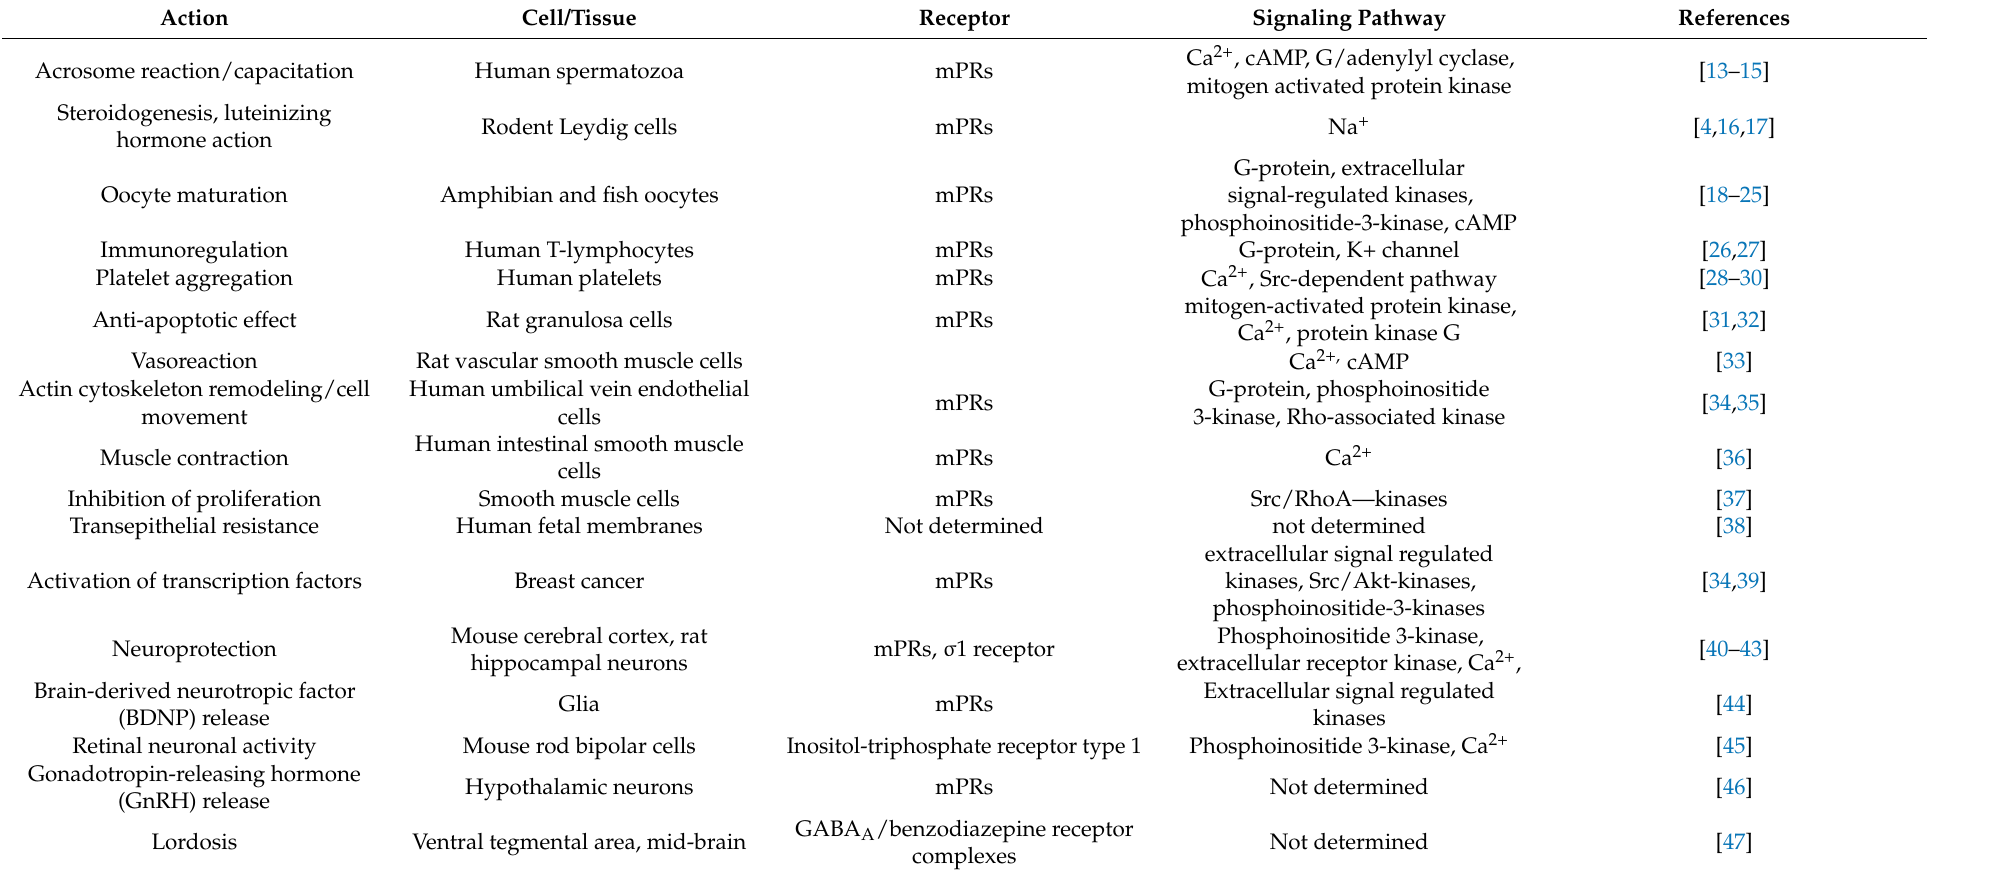
Table 1. Non-genomic effects of progesterone across humans and animals. In the given receptor types, mPRs represent membrane progesterone